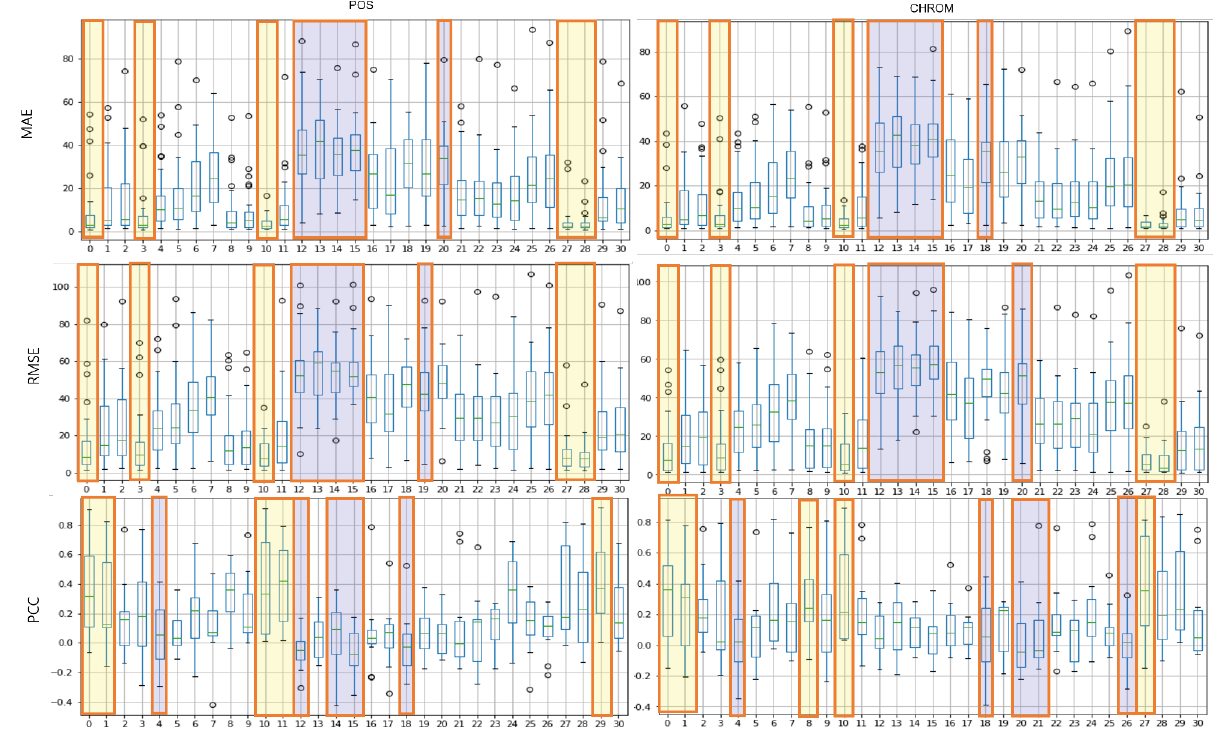
Figure 7. Performance evaluation of proposed ROIs on UBFC data (yellow: TOP-5, blue: BOT-5).